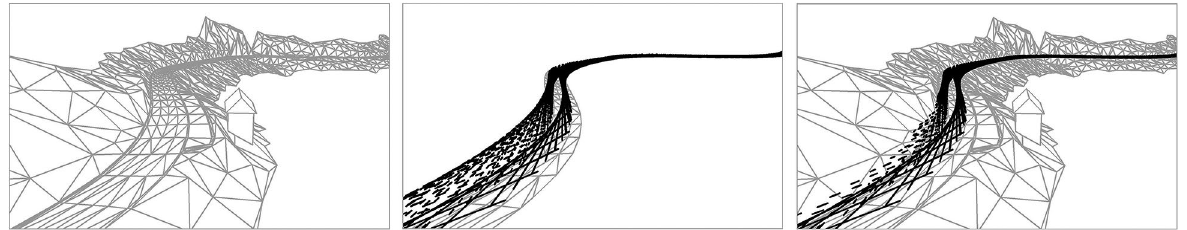
Fig. 7. Importing lines of sight into the triangulated model